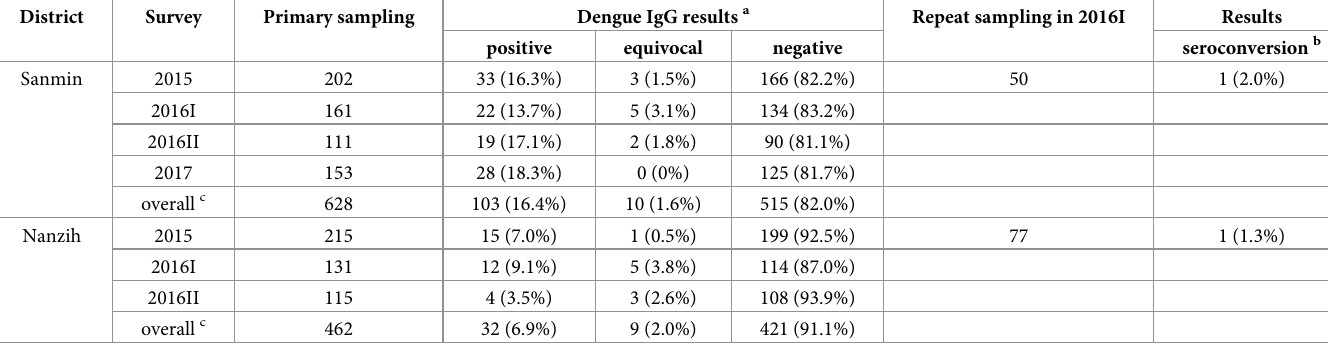
Table 1. DENV seroprevalence rates in two districts of Kaohsiung City.